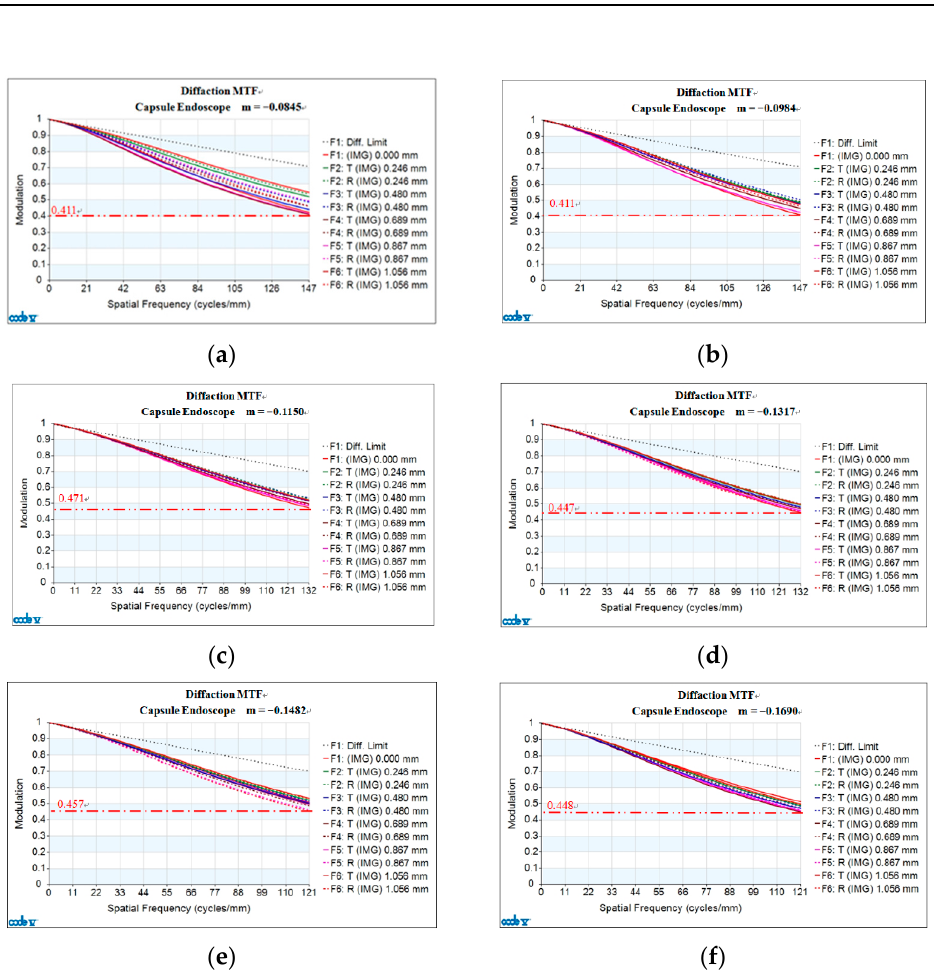
Figure 4. MTF curves for a 2× zoom lens at different magnifications: ( a ) M = − 0.0845; ( b ) M = − 0.0984; ( c ) M = − 0.1150; ( d ) M = − 0.1317; ( e ) M = − 0.1482; (f) M = − 0.1690. Table 2. Comparison of maximum optical distortion at different